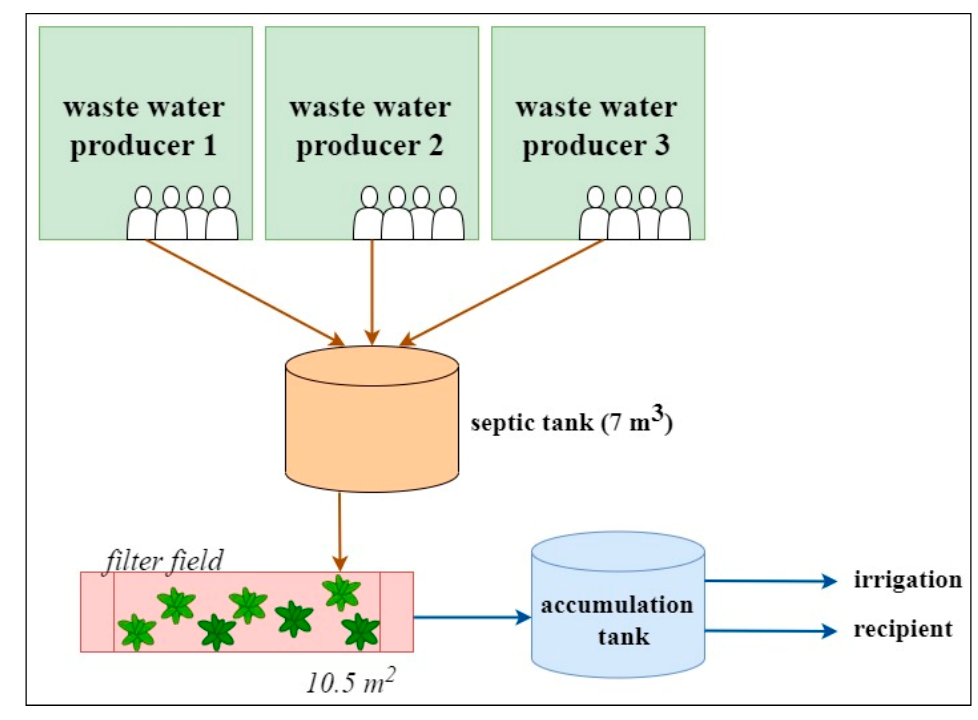
Figure 2. The scheme root WWTP type ECOkocka [19].